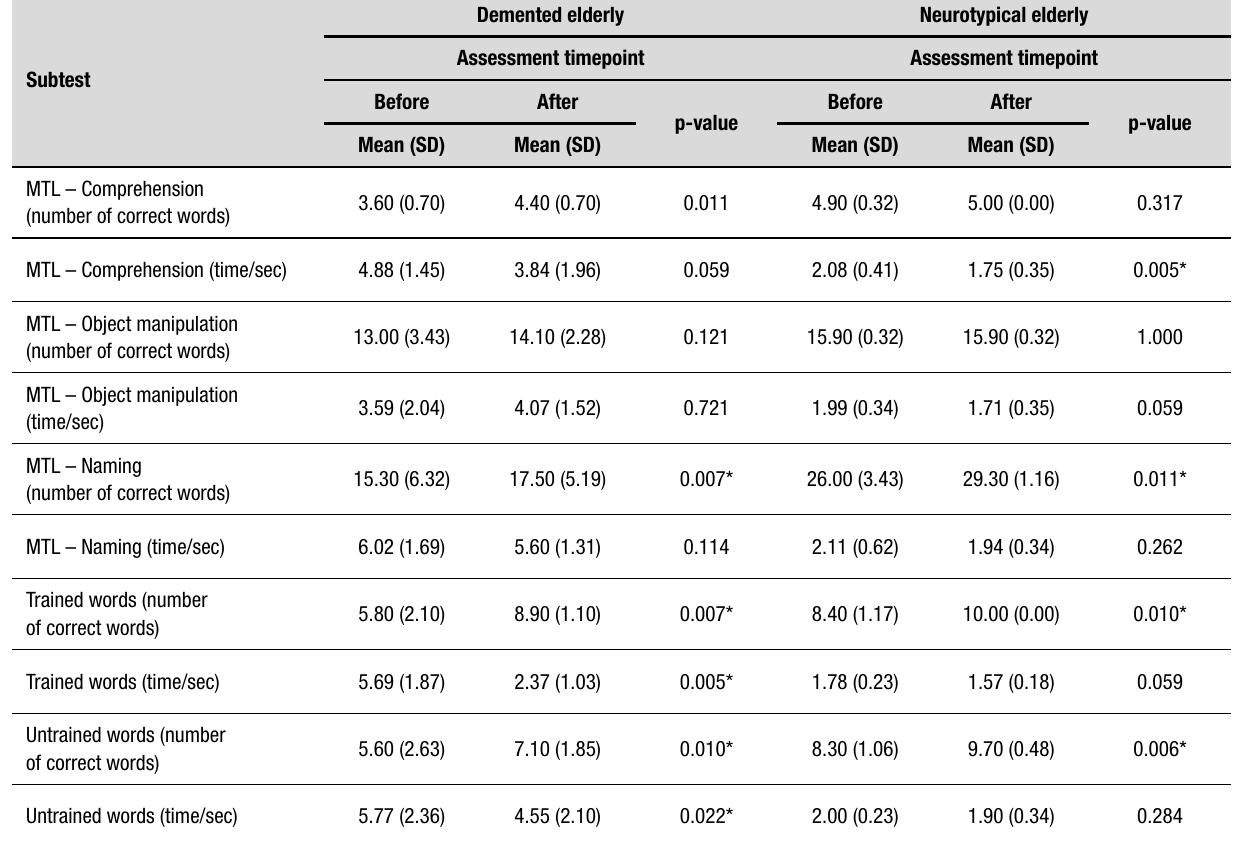
Table 2. Language performance before and after naming training, by group studied.